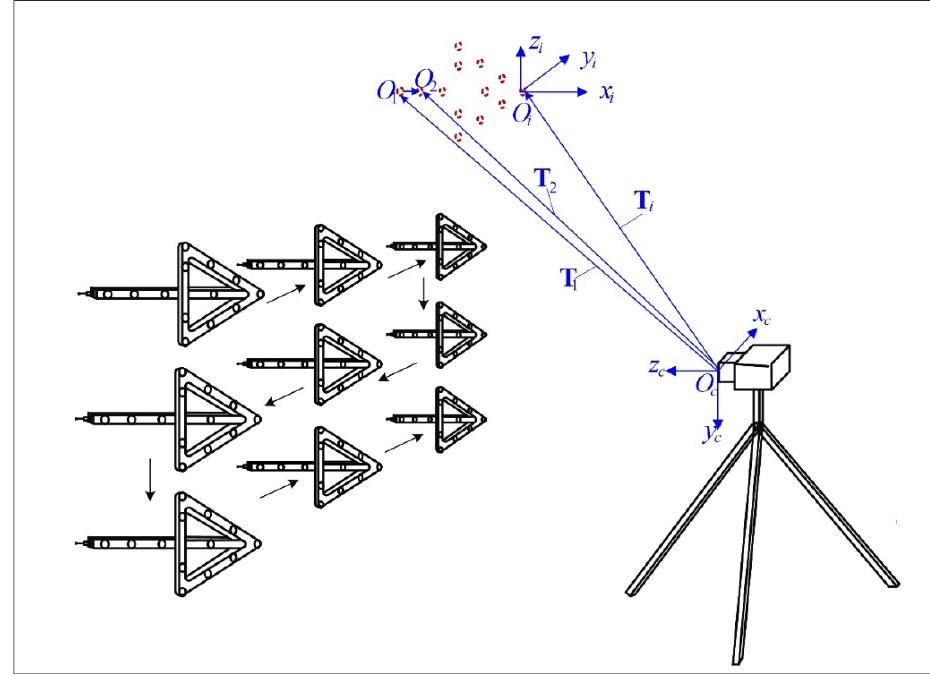
Figure 3. The relationship between the control point coordinate systems and the camera coordinate system. Determining the relative positions of the origins of control point coordinate systems can be converted to calculating the translation vectors between the control point coordinate systems and the camera coordinate systems.